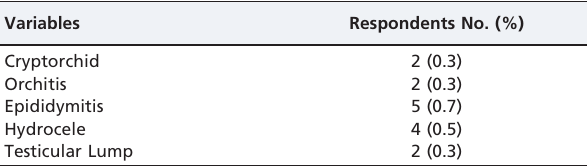
Table III - Testicular Abnormalities Discovered While Practicing TSE As Instructed.